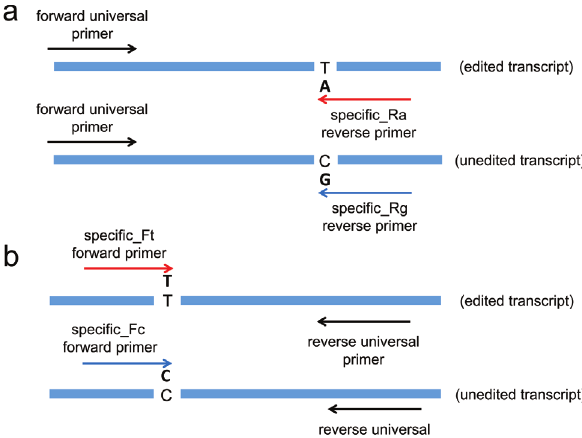
Figure 1 - Schematic illustration of qPCR analysis of RNA editing fre- quency showing relative locations of (A) specific-reverse and (B) spe- cific-forward qPCR primers. Arrows depict the annealing sites of qPCR